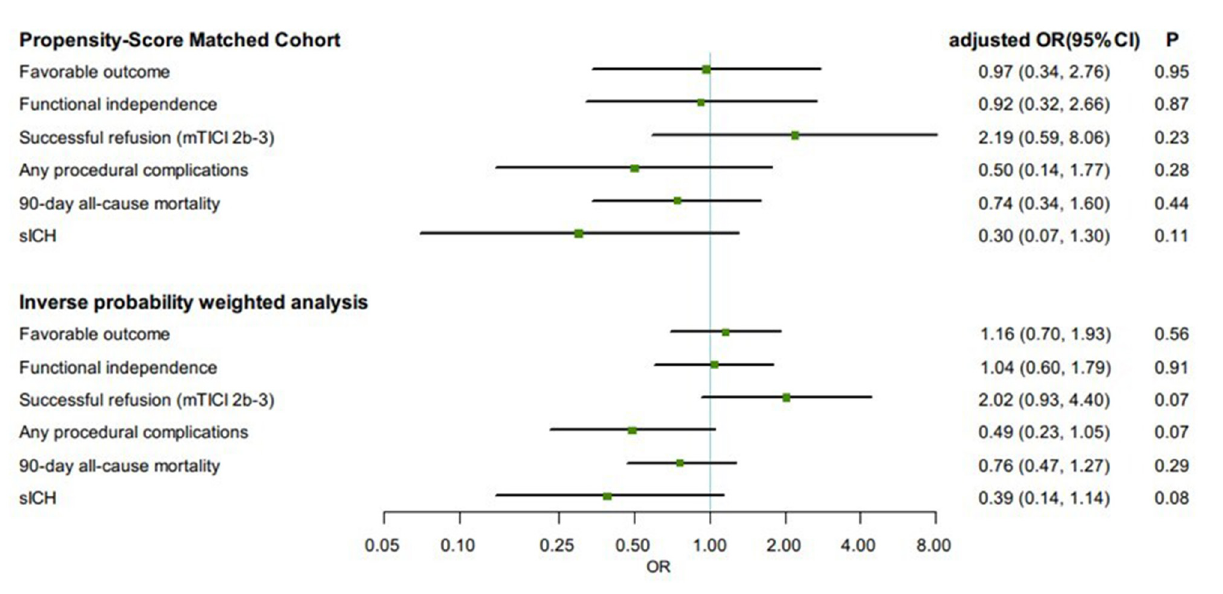
FIGURE2 Comparisons in clinical and angiographic outcomes according to first-line anesthetic approach in patients treated with thrombectomy in matched and inverse probability of treatment weighting (IPTW) analyses. CI, confidence interval; mTICI, modified thrombolysis in cerebral infarction; OR, odds ratio; sICH, symptomatic intracranial hemorrhage. All regression analyses were adjusted for the following variables: age, sex, atrial fibrillation, smoking history, systolic blood pressure, glucose, site of occlusion, Glasgow Coma Scale score, baseline NIH Stroke Scale score, IV thrombolysis, pneumonia, time from estimated occlusion to groin puncture, door to groin puncture, and groin puncture to